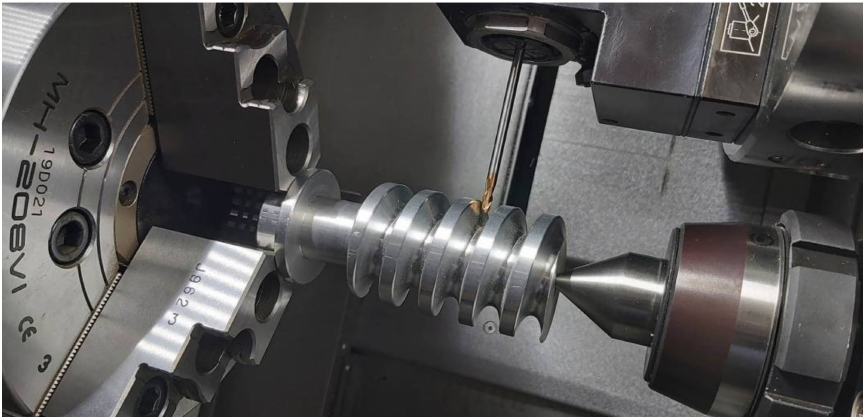
Figure 7. The machined worm mounted in a three-jaw chuck (CNC lathe: DMG MORI CLX350V4).